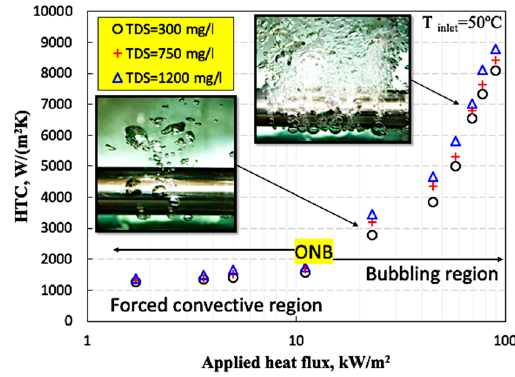
Figure 5. Heat transfer rate vs. thermal flux for different total dissolved solid materials (TDS) values and bubble formation as a function of heat flux at TDS = 300 mg/L.